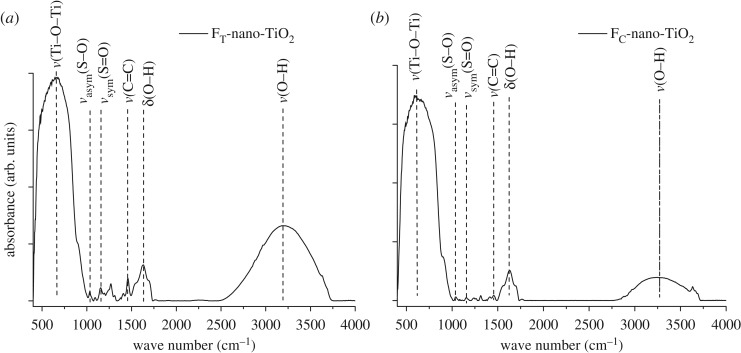
FTIR spectra of organofunctionalized nano-TiO2, (a) FT-nano-TiO2 and (b) FC-nano-TiO2.